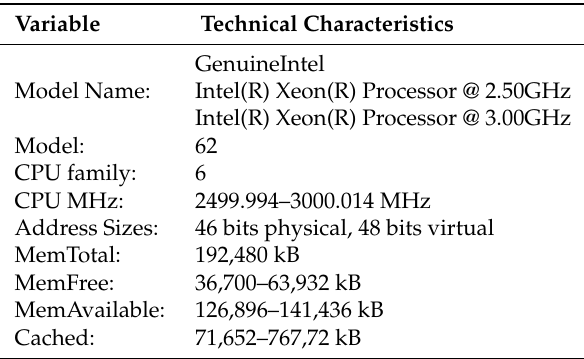
Table 11. Intervals Processor Information